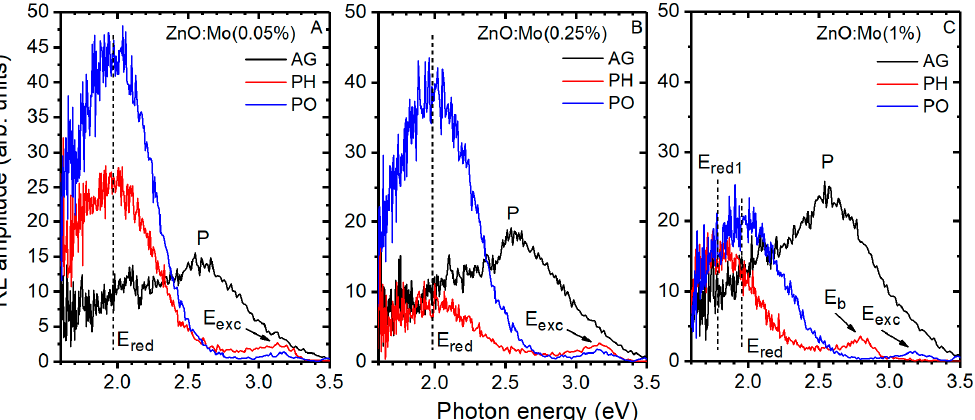
Figure 7. Room temperature RL spectra of ZnO:Mo(0.05%) ( A ), ZnO:Mo(0.25%) ( B ) and ZnO:Mo(1%) ( C ), AG, PH or PO. E red , E red1 , E b , E exc and P stress emission bands of different origin.